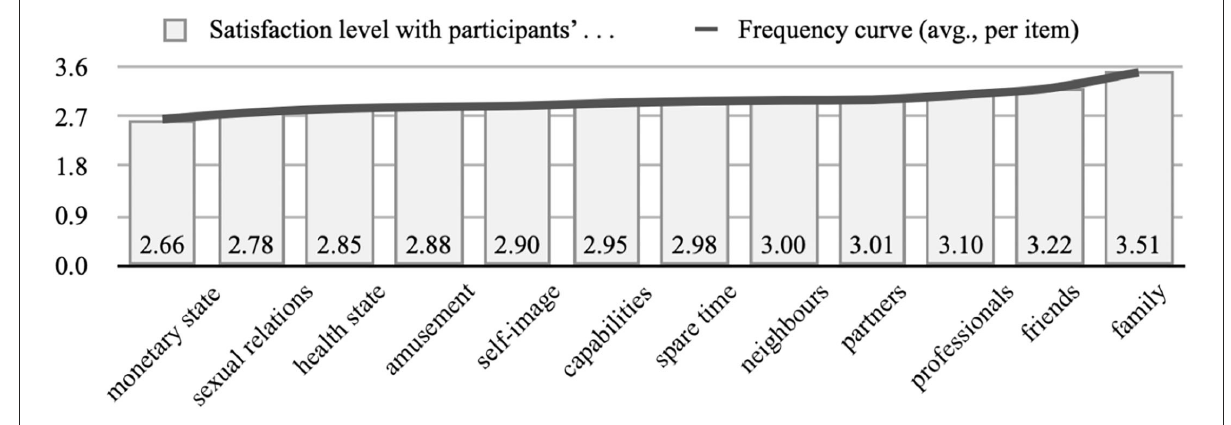
FIGURE1 Averaged satisfaction levels with the different aspects of